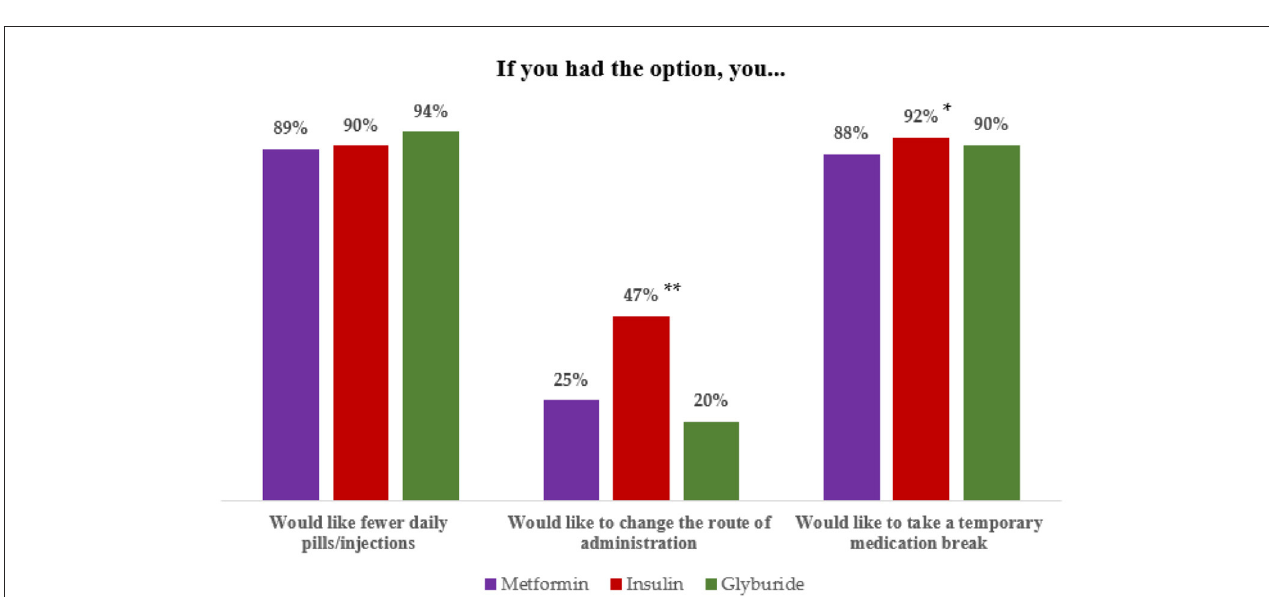
FIGURE1 Idealistic expectations according to type of medication. Information at the bottom of the figure: z test for the difference between two proportions p values: * < 0.05, Insulin > Metformin, ** < 0.001, Insulin > Metformin and glyburide.